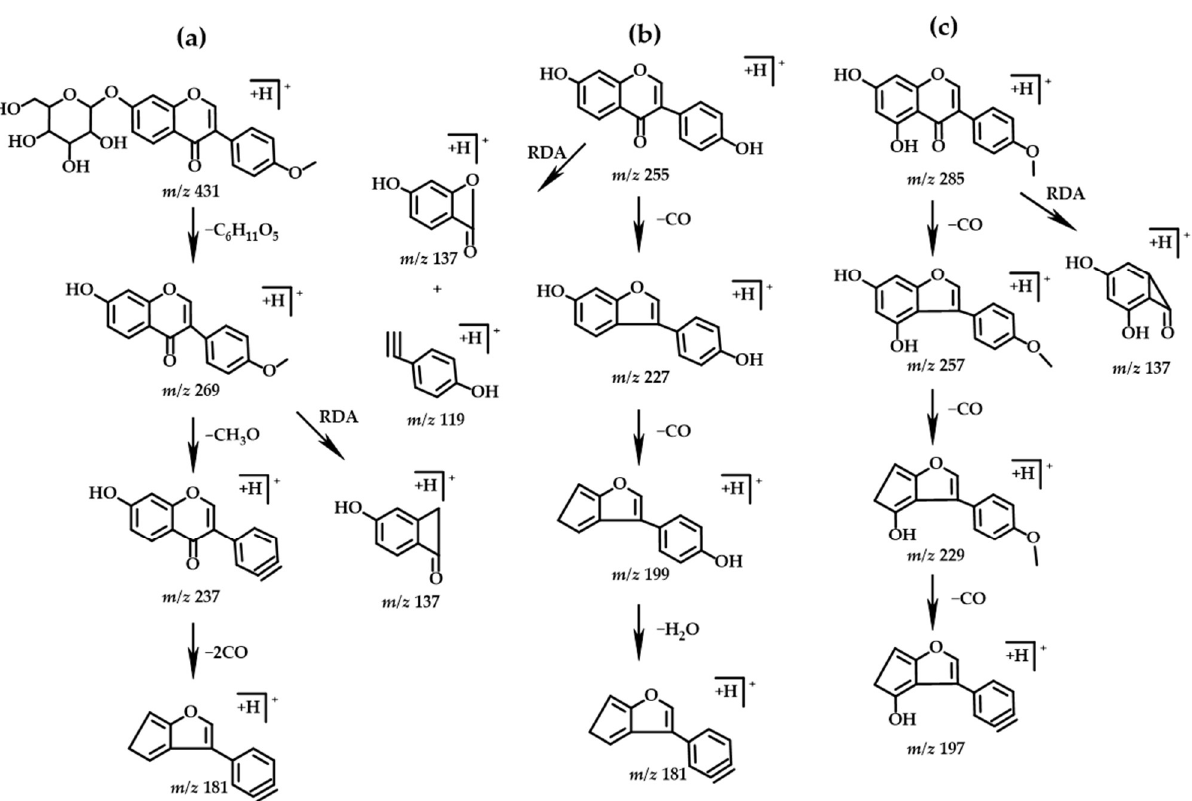
Figure 4. Chemical structure and fragmentation pathways of ( a ) ononin, ( b ) daidzin, and ( c ) bio- Figure chanin A.